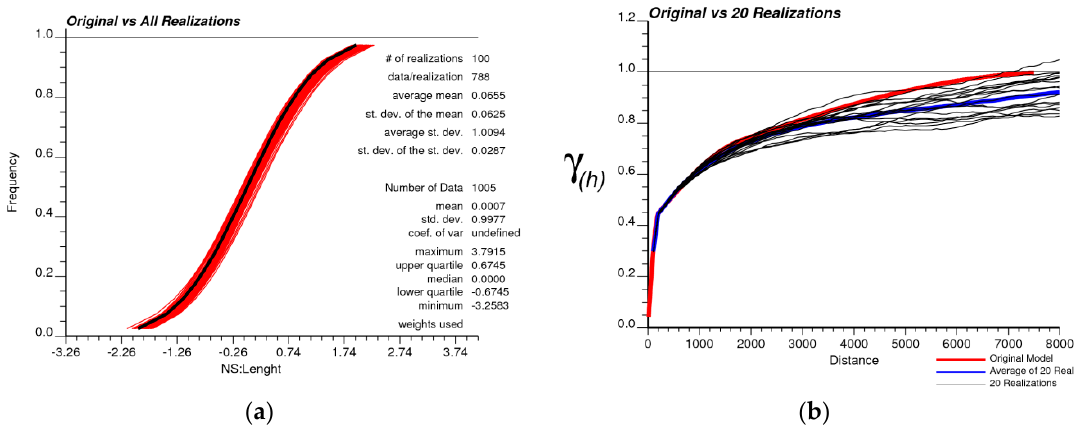
Figure 11. ( A ) Cumulative curve for 100 realizations compared to the original data and ( B ) vario- grams for 20 realizations compared to the original data.